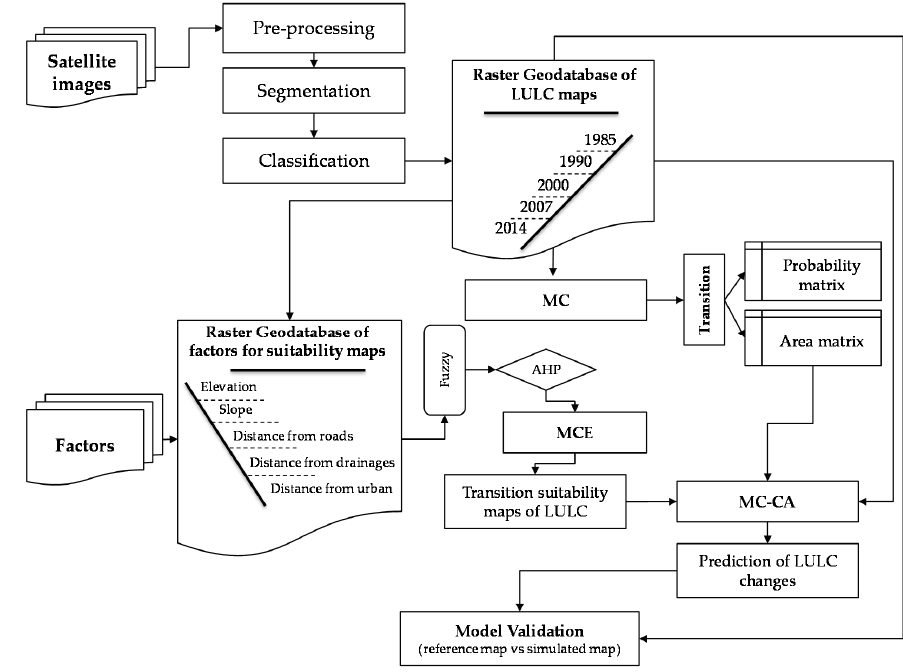
Figure 2. Flowchart of the research methodology.